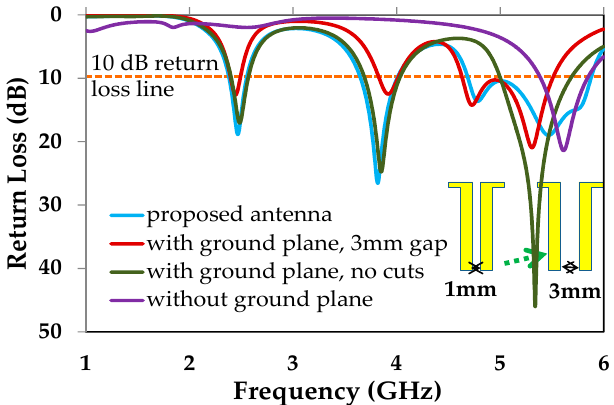
Figure 5. Parameter test observations of the antenna structure.